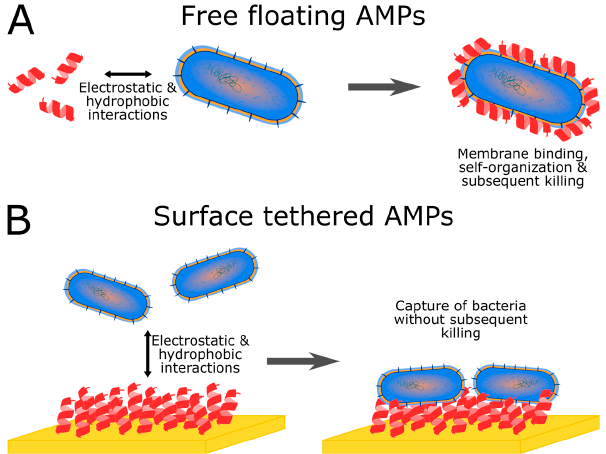
Figure 1. Tethering AMPs can prevent the triggering of killing mechanisms of the bacteria. ( A ) Free floating peptides can self-organize onto the bacterial membrane and subsequently disrupt it or insert themselves inside the cell in order to kill it. ( B ) Tethered peptides can no longer self-organize at the surface of the bacterial membrane, thus inhibiting their bactericidal activity. Interaction abilities can, however, still be conserved, thus allowing the design of capture surfaces for biosensing